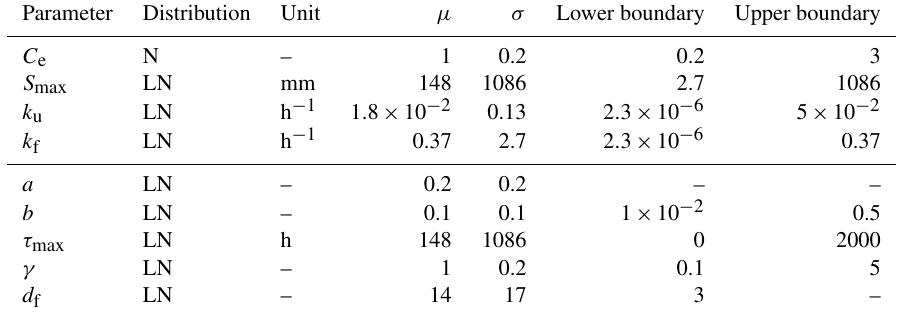
Table 3. Prior distributions of the hydrological and error model parameters applied in all the cases where the respective parameter was used. N = Gaussian normal; LN = log-normal. Where lower and upper boundaries are listed, the distribution is truncated at those values. Parameter Distribution Unit Lower boundary